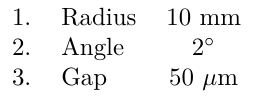
Table 1. Characteristic features of the cone-plate geometry.